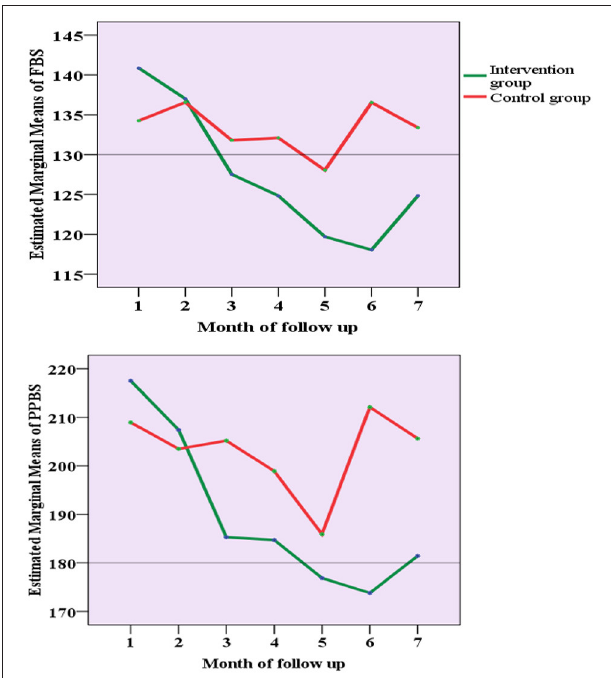
FIGURE 3 | The trend of the estimated marginal mean of FBS and PPBS values over the follow-up